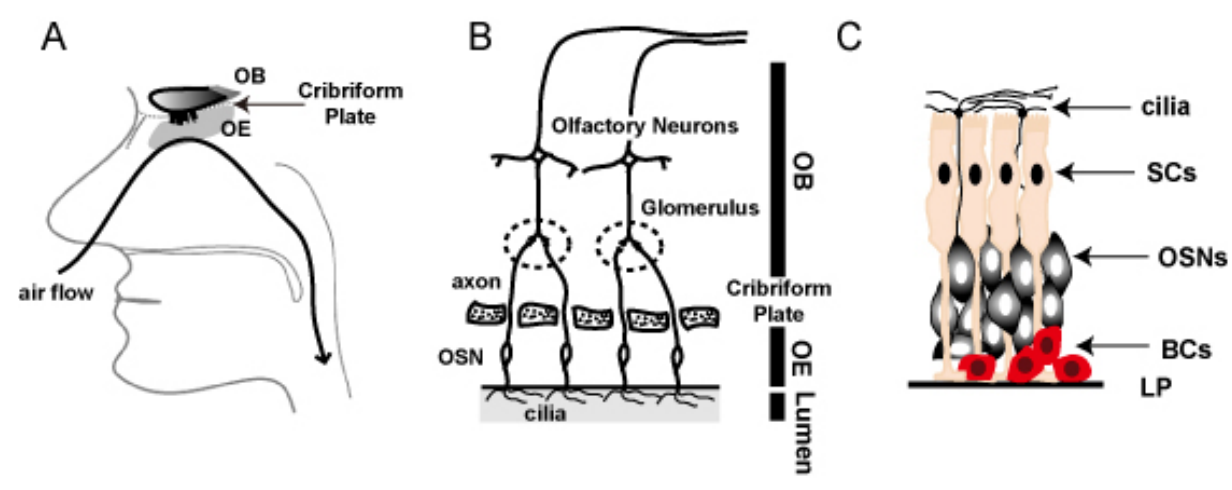
Figure 1. Anatomy of the olfactory